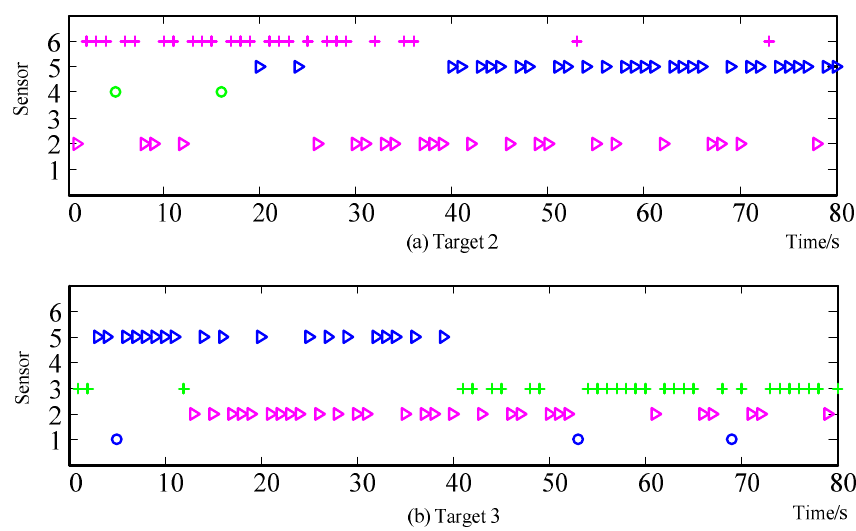
Figure 15 . Sensor selected sequences obtained by IPFSP. ( a ) Target 2; ( b ) Target 3.